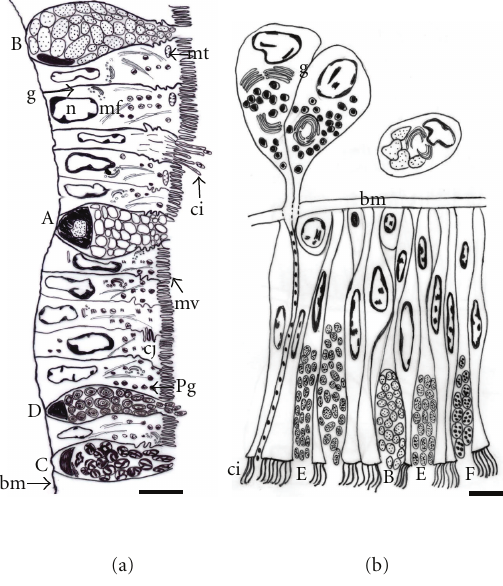
Figure 1: Schematic drawing of the side (a) and sole (b) foot epithe- lia. Secretory cells (A, B, C, D, E, and F), basal membrane (bm), cilia (ci), Golgi complex (g), cell junctions (cj), microfilaments (mf), mitochondria (mt), microvillus border (mv), nuclei (n), and pigmented granules (pg). Bar: 10 µ m (a), 5 µ m